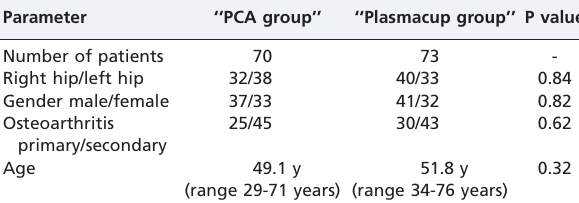
Figure 3 - Kaplan-Meier analysis of implant